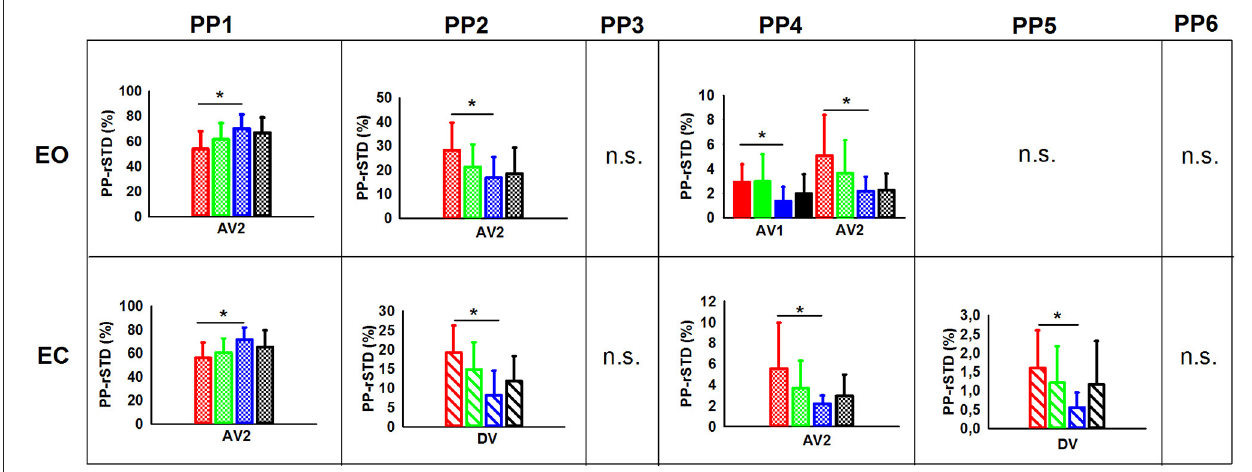
FIGURE 3 | PP (principal postural movement components) means and standard deviations for the children [non-gymnasts (C-NG) in red and gymnasts (C-G) in green] and adults [non-gymnasts (A-NG) in blue and gymnasts (A-G) in black] by visual condition (EO, eyes open; EC, eyes closed). Phases were shaded differently (BV, before vibration; DV, during vibration; AV1, after vibration early phase; AV2, after vibration late phase), but only phases with significant differences between groups were plotted. Asterisks (*) indicates significant differences from planned comparisons; n.s. indicates non-significant results.